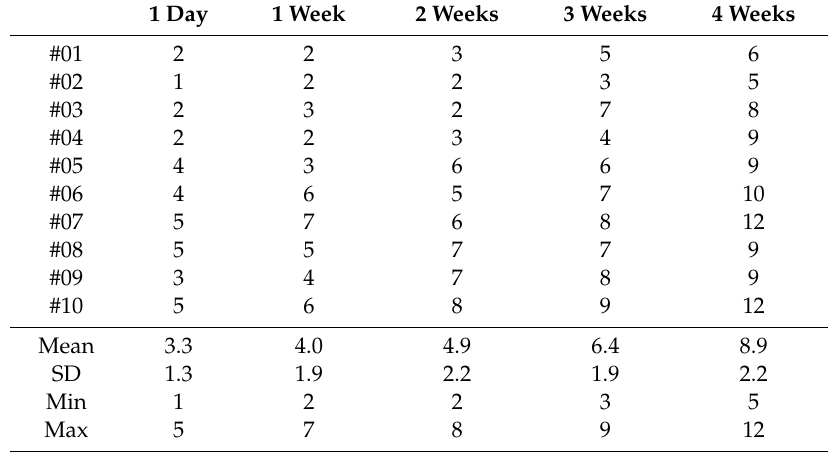
Table 1. Deviation (in µ m) of the 3D-printed models #01–#10 from the reference model after aging of 1 day; 1 week; and 2, 3, and 4 weeks (SD = standard deviation, Min = minimum, and Max = maximum).